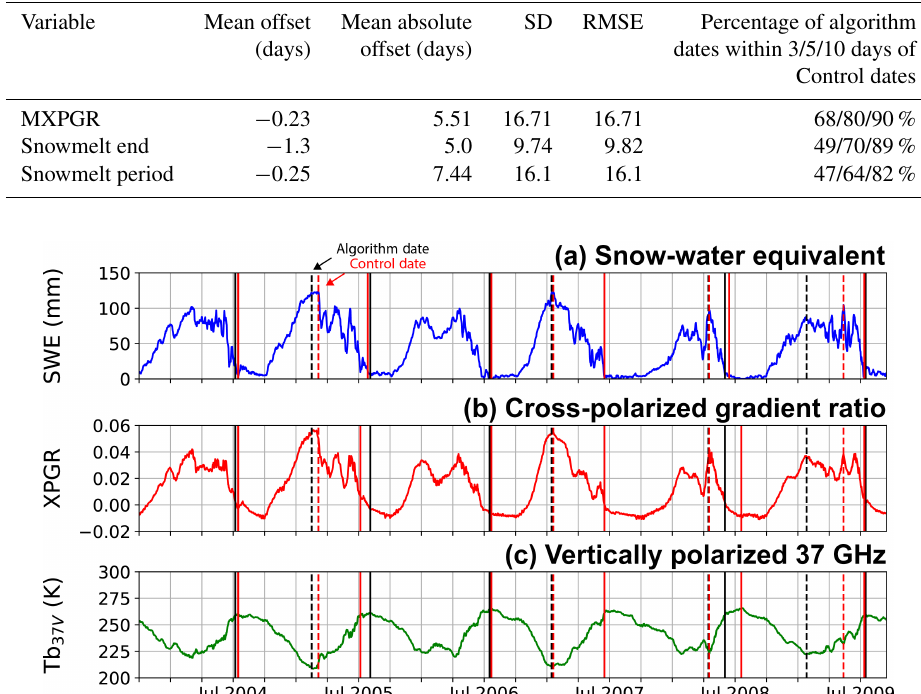
Figure 3. Sample data from 71.25E, 36.75N (see Fig. 1) showing (a) snow-water equivalent (SWE) based on the Chang algorithm (Chang et al., 1987), (b) cross-polarized gradient ratio (XPGR), and (c) vertically polarized temperature brightness at 37GHz (Tb 37V ) measurements. MXPGR (dashed lines) and end of melt (solid lines) are black for algorithm dates and red for control dates. Lack of red lines indicates temporal overlap of algorithm and control dates. Years with multiple distinct peaks (e.g., 2004, 2006) are flagged as unconstrained and not used for further